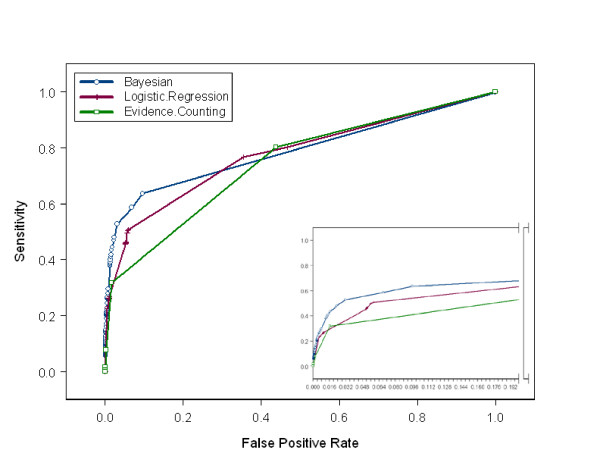
The relationship between false positive rate and sensitivity for predicting domain interactions using different methods : evidence counting, logistic regression, and naive Bayesian.